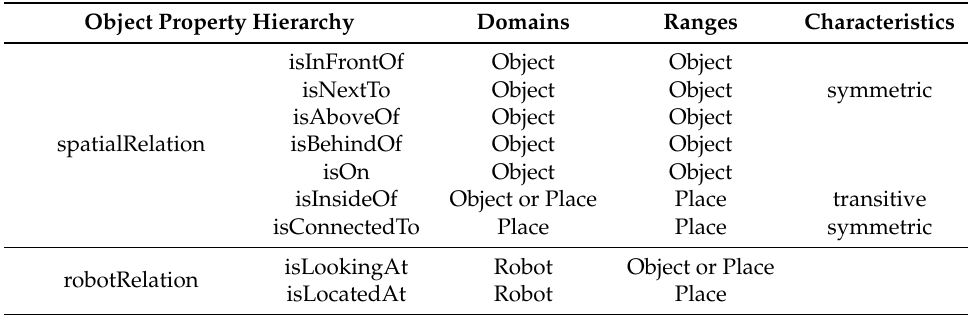
Table 2. Object properties.